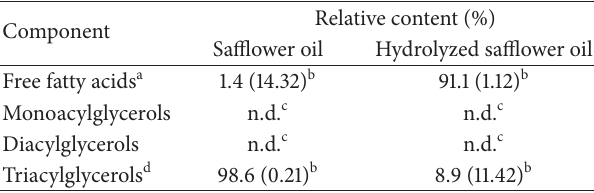
Table 1: Relative content of safflower oil and its hydrolyzed product in free fatty acids, mono-, di-, and triacylglycerols, as determined by high-performance liquid chromatography